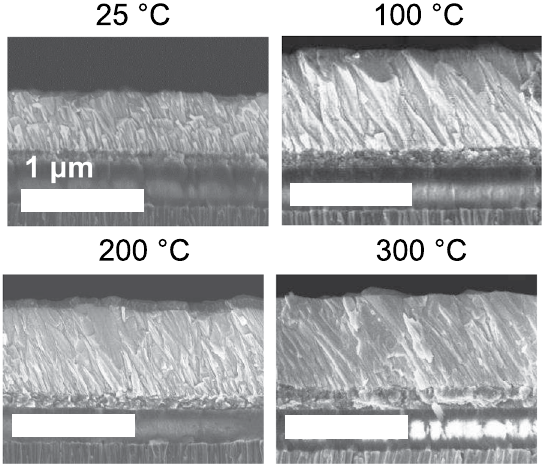
Figure 3. SEM cross-sections of the same magnification (25,000) of the ZnO films deposited on the Al surfaces at different T S , showing an appreciable inclination of ~30° from the surface normal. Uniform inclinations are observed at 100 °C, 200 °C and 300 °C. At 25 °C, the ZnO inclination is discontinuous as the film thickness increases. All scale bars represent 1 µ m. The last two reflector layers of SiO 2 and Mo are observable and the ZnO film for T S is ~200 nm thinner due to rapid decrease of the deposition rate over a short distance across the